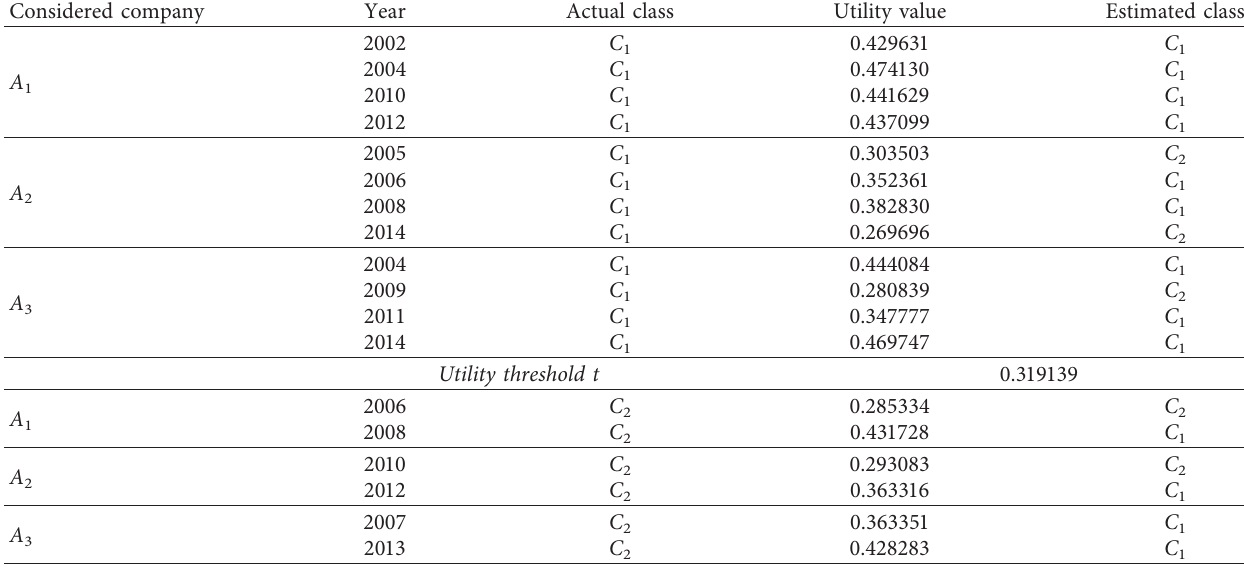
Table 7: Forecasting results using the trained single UTADIS model (training dataset).